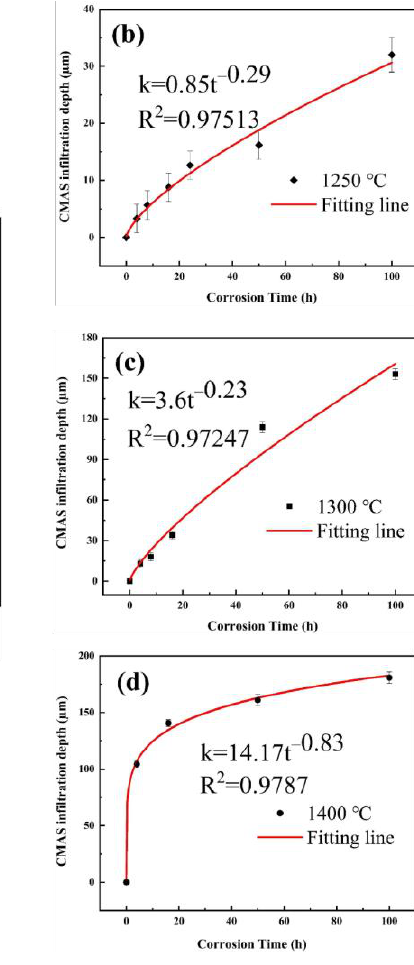
Figure 5. ( a ) Evolution of CMAS infiltration depth with time in Hf 6 Ta 2 O 17 ceramic at different temperatures; ( b – d ) Expanded view of infiltration depth with time in Hf 6 Ta 2 O 17 ceramic at 1250, 1300 and 1400 °C, respectively. R 2 represents the value of the matching